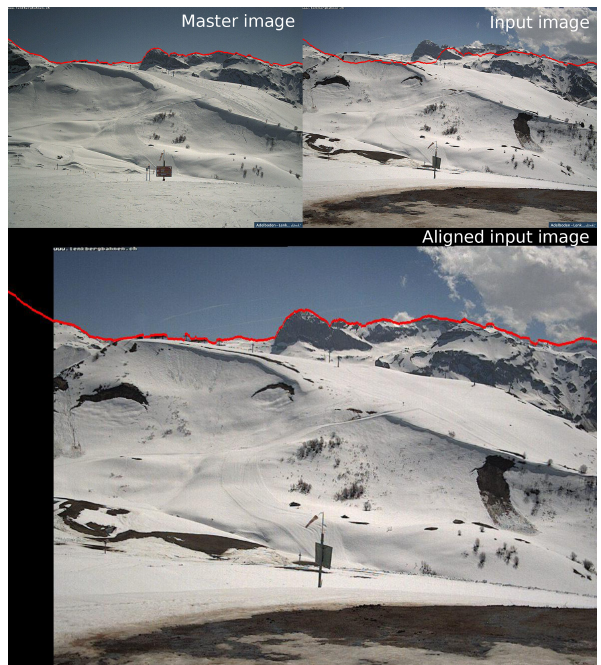
Figure 9. Example of an arbitrary input image that is aligned to a corresponding master image. The mountain silhouette extracted from the master image is shown in red. Webcam images: Hahnen- moos, © Skiregion